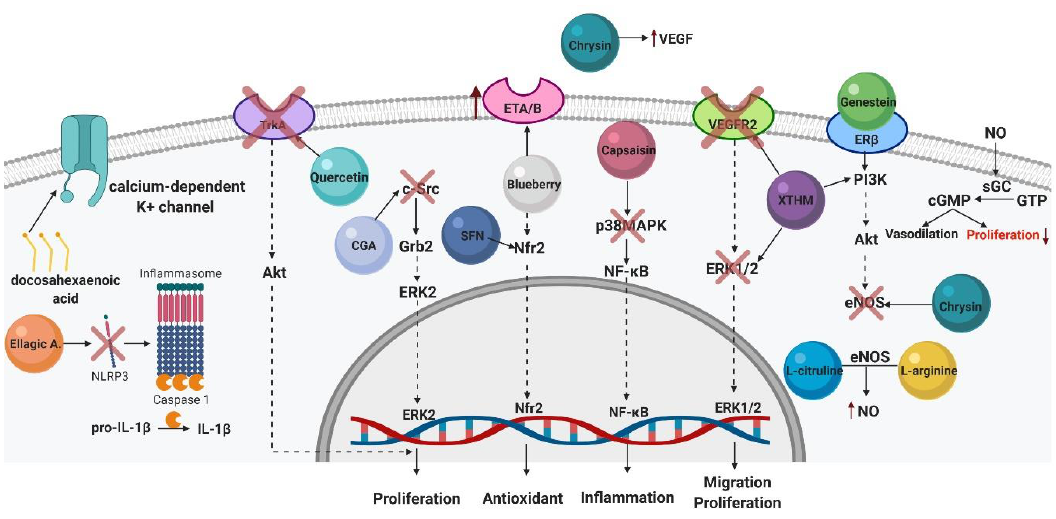
Figure 3. Participation of nutraceuticals in the signaling pathways involved in the development of PAH. TrkA: Tropomyosin receptor kinase A; Akt: Protein Kinase B; c-Src: Proto-oncogene tyrosine- tyrosine-protein kinase Src; Grb2: Growth factor-bound protein 2; ERK2: